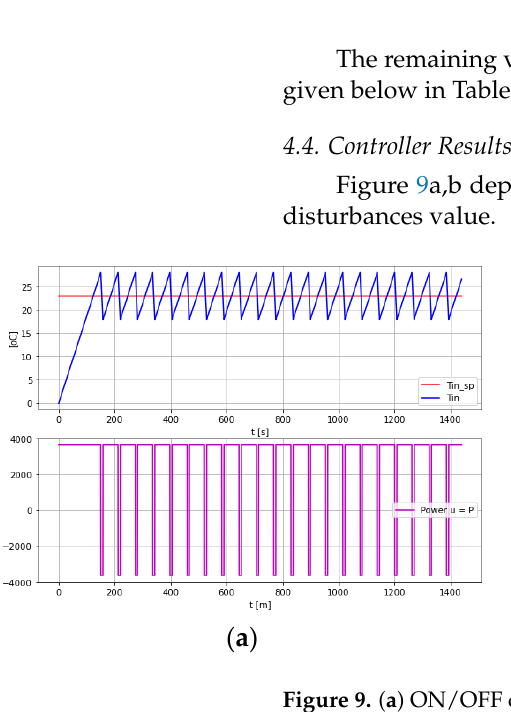
Table 5. Trial and error PI and ON/OFF control parameters.